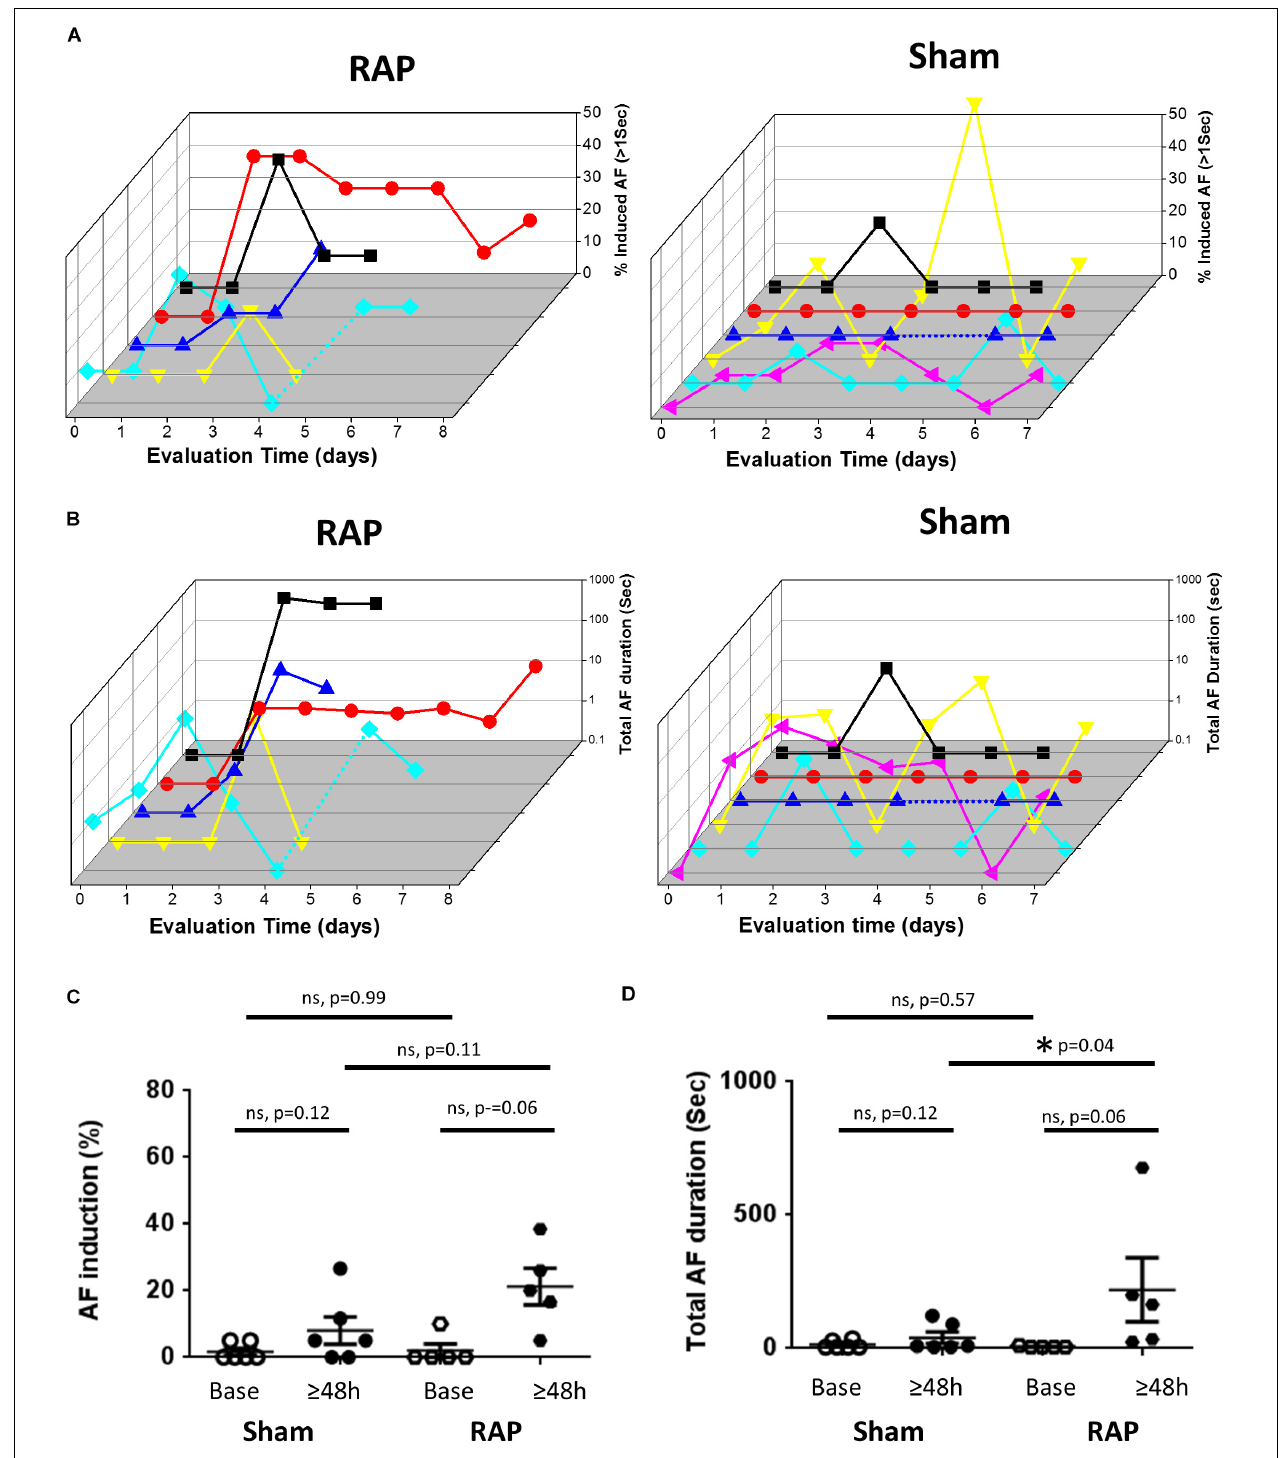
FIGURE 2 | Increased AF substrate in rats exposed to RAP. (A) Analysis of AF induction. 3D plots of daily evaluation in five RAP rats (left) and six Sham rats (right). In both plots each color represents a different rat. For the RAP animals evaluation was continued until capture was lost or was too high to keep with the RAP. For the Shams, evaluation was maintained for 6–8 days. Note absence of AF induction in the majority of rats at baseline as well as following 1 day of RAP. Also note increased AF substrate following 2 days of RAP. (B) Analysis of Total AF duration. 3D representation as in (A) above. (C,D) Comparison of the AF substrate parameters before and after 2 days in the RAP vs. Sham rats. Note the strong tendency of increase in AF induction and AF duration following 2 days in the RAP group. Also note increased AF duration following 2 days in the RAP group vs. the Sham group.